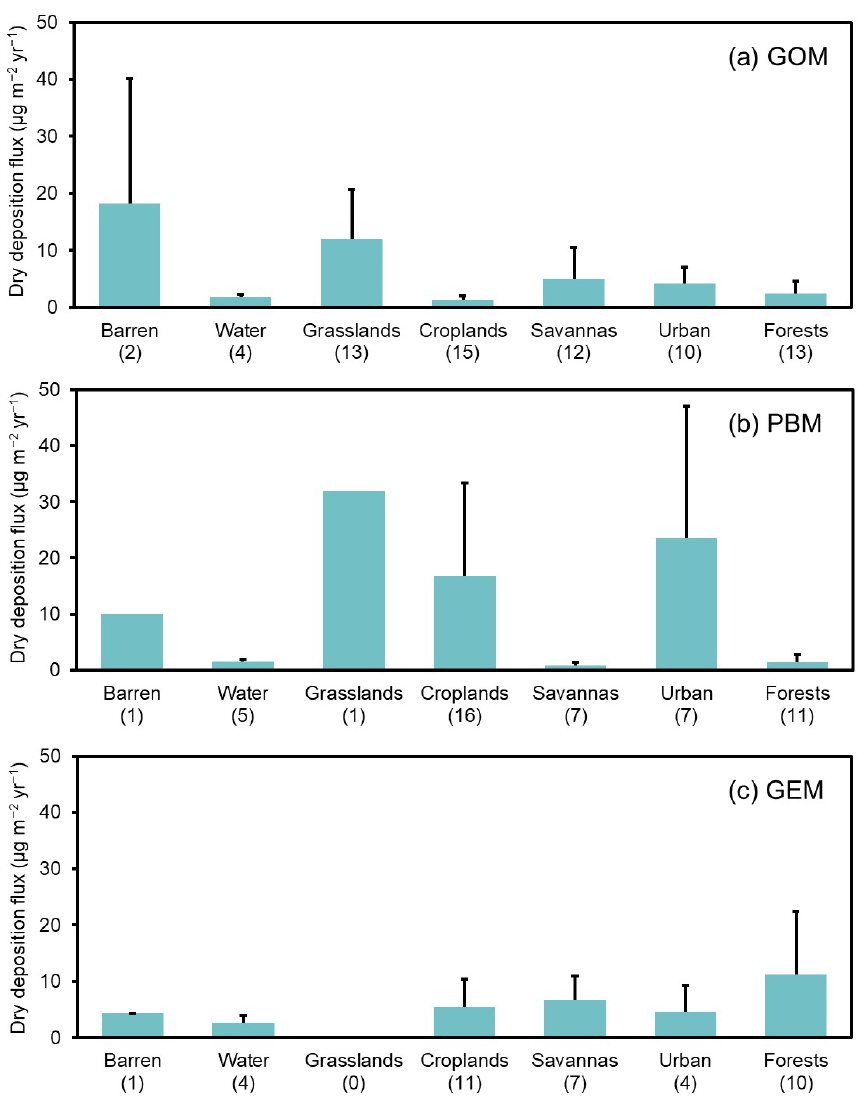
Figure 5. Dry deposition fluxes (cyan columns with black bars as standard deviations) of (a) GOM, (b) PBM, and (c) GEM for different terrestrial surface types. “Water” stands for the terrestrial surfaces near water. The numbers in brackets stand for the numbers of